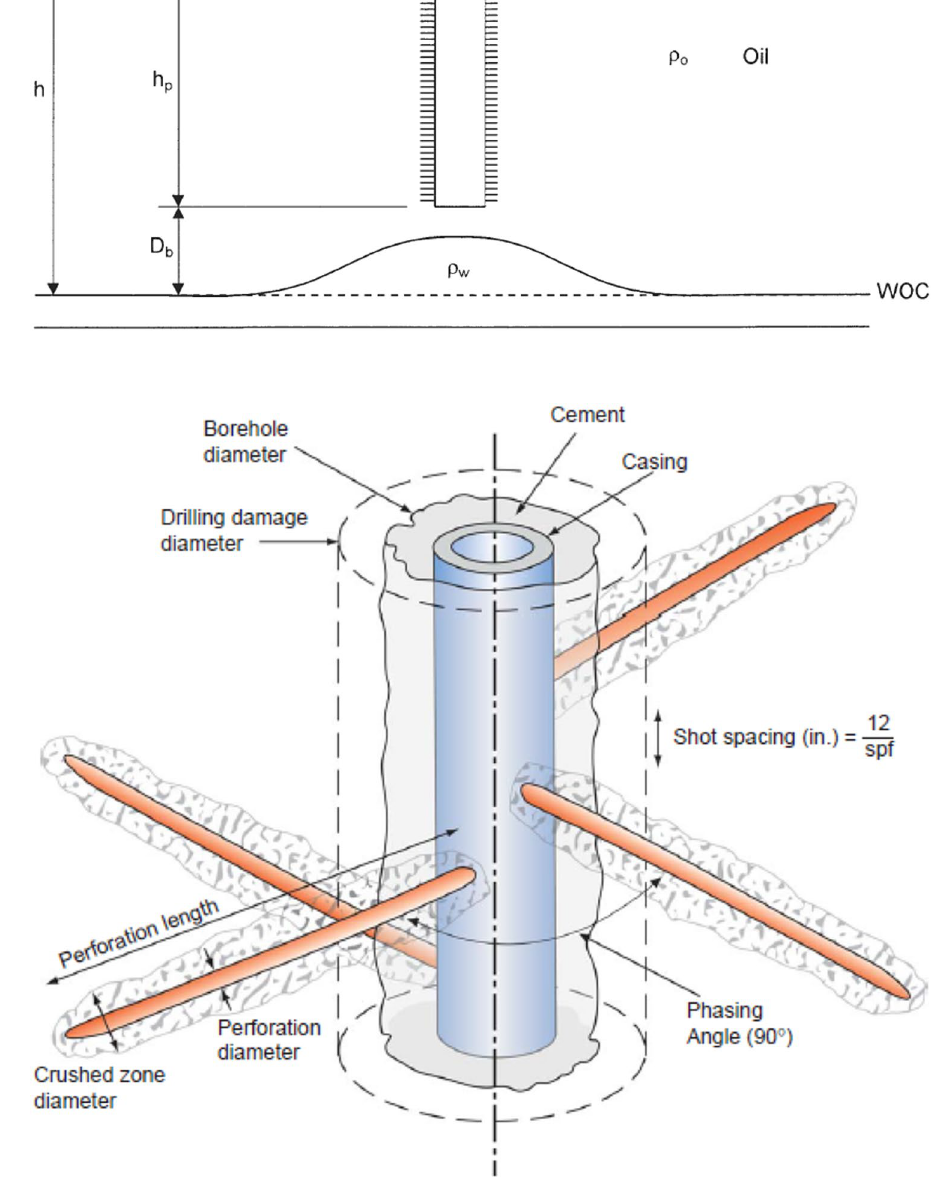
Fig. 1 A perforated interval showing both the original reservoir static condition and water coning after the onset of production where h is the oil column thickness, h p is the well-perforated interval, WOC is water–oil contact, D b is the distance from the bottom of the perforations to the original WOC, ρ o is oil density and ρ w is